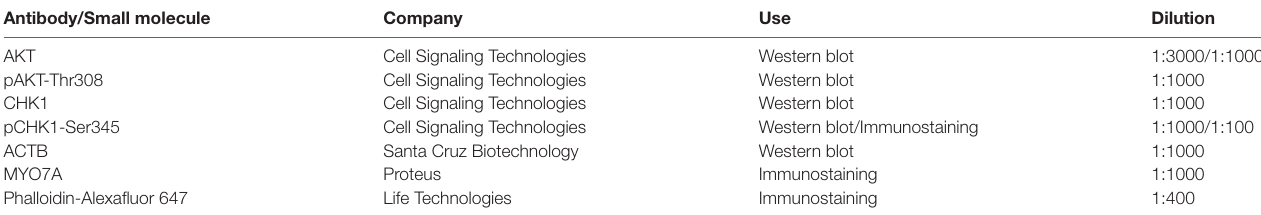
TABLE 1 | Antibodies and Small Molecules. Antibody/Small molecule